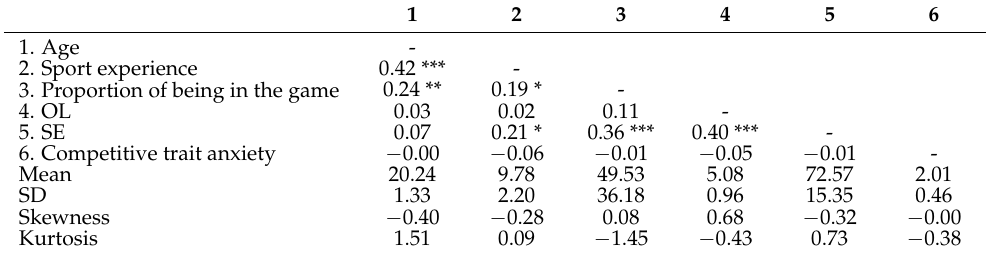
Table 2. Descriptive Statistical